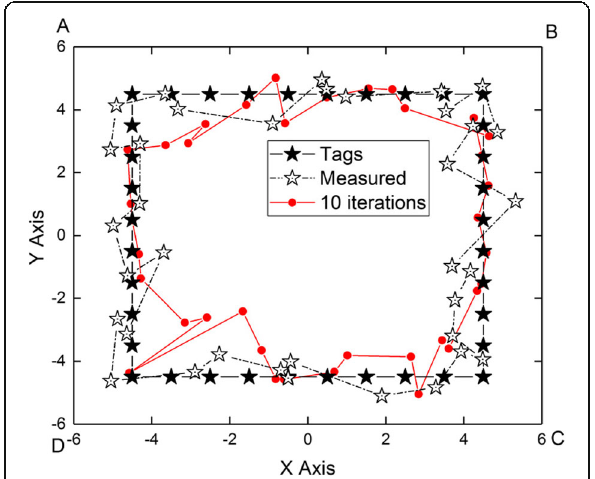
Fig. 10 Results of 10 iterations for 2D indoor localization. We illustrate the optimized position for each target after 10 iterations, which is denoted by the red dots. It can be found that the locations